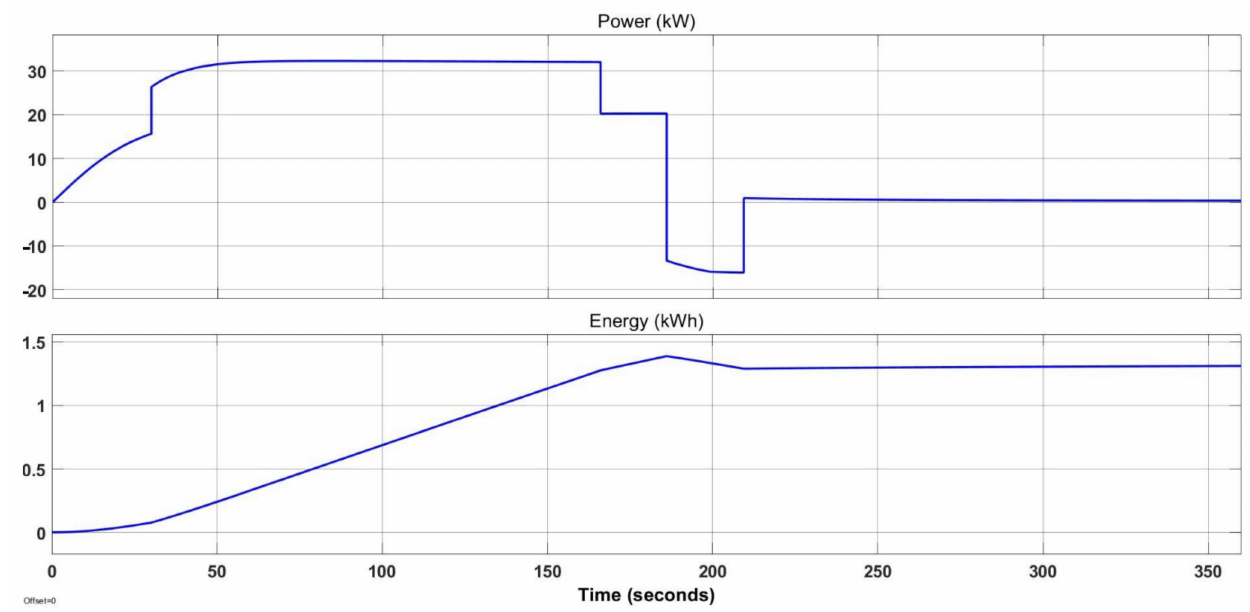
Figure 12. Power demand and energy consumption of electric WT-9 Dynamic—tow at height 300 m.